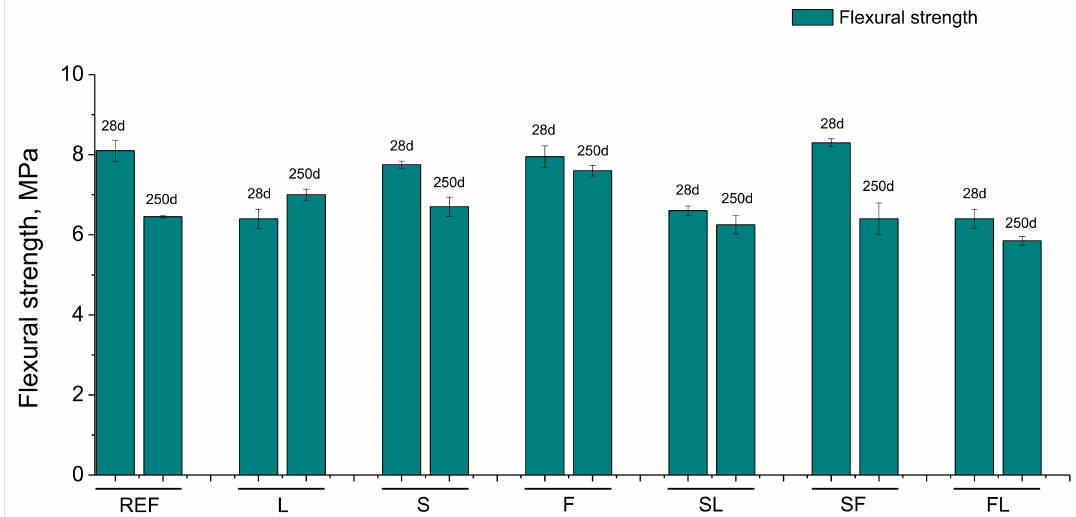
Figure 13. Results of flexural strength noted for the analyzed